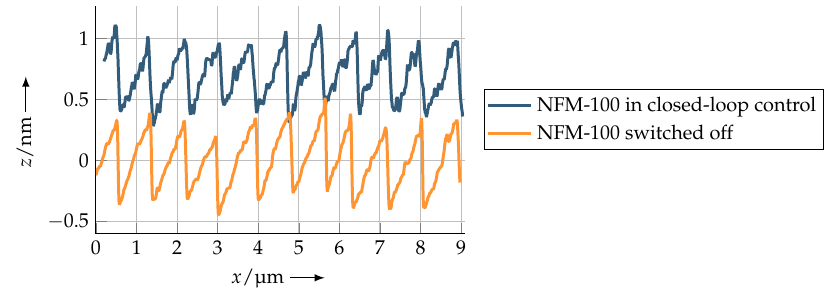
Figure 13. Non-contact AFM images of a 6H-SiC [28] sample with a step height of 0.75nm with the machine table of the NFM-100 switched off ( left ) and the table switched on in closed-loop control ( right ). The scanning speed for this measurement was 5µm/s.